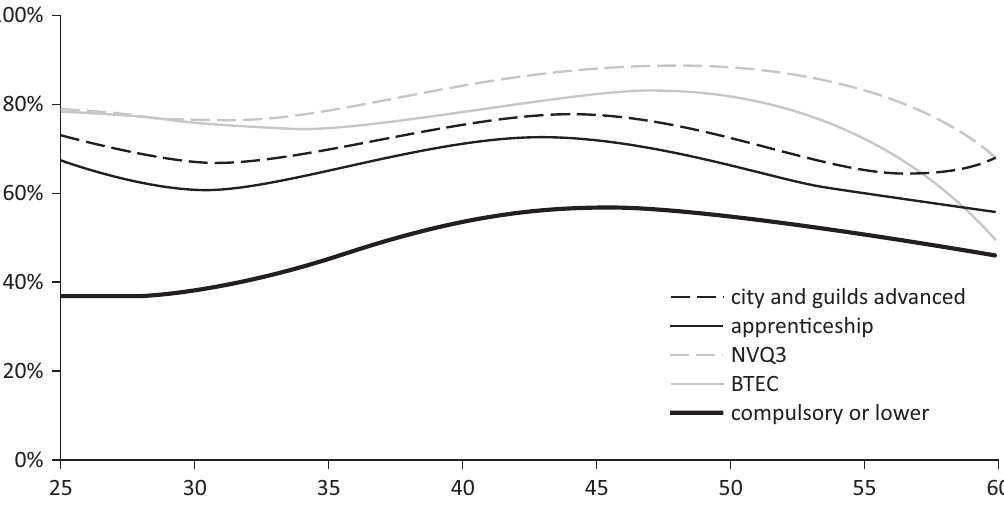
Figure A3. Employment rate (minimun 8 hours per week) by type of upper-secondary vocational education. Women— United Kingdom. Source: UK Labour Force Survey